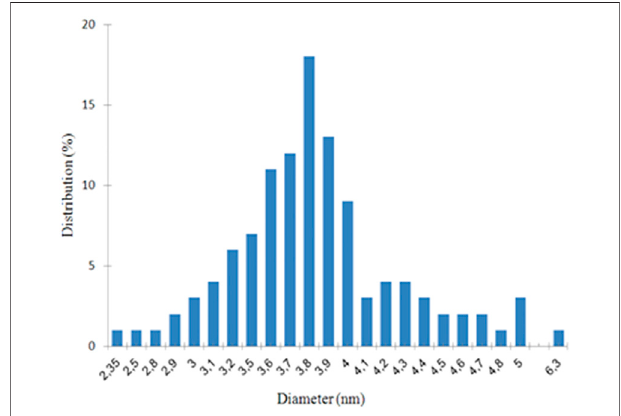
FIGURE 5 | Time and dose dependence of cytotoxicity on IB115 sarcoma cells line. D1 is after 1 day and D3 is after 3